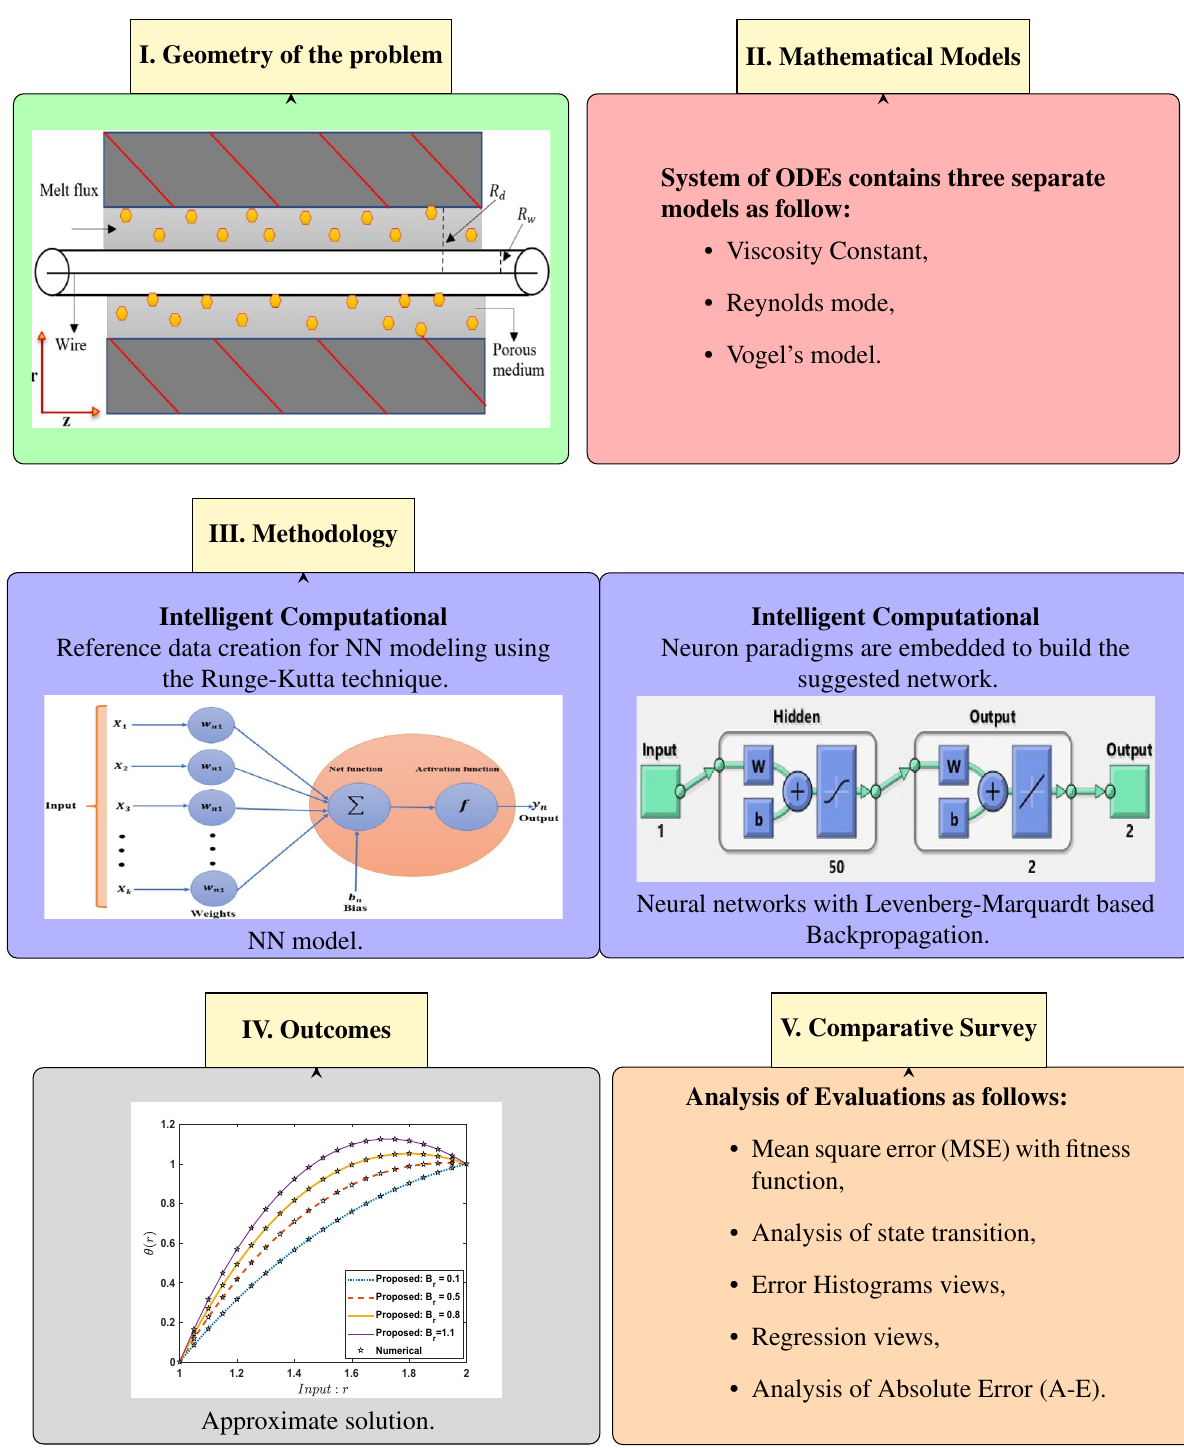
Figure 3. Scheme operation of the suggested LMA-TNN for the wire coating